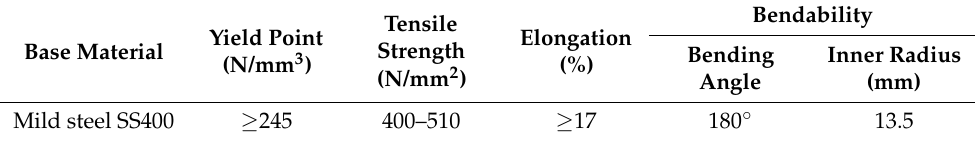
Table 2. Mechanical properties of mild steel SS400 for 9 mm plates (JIS G 3101-2015).